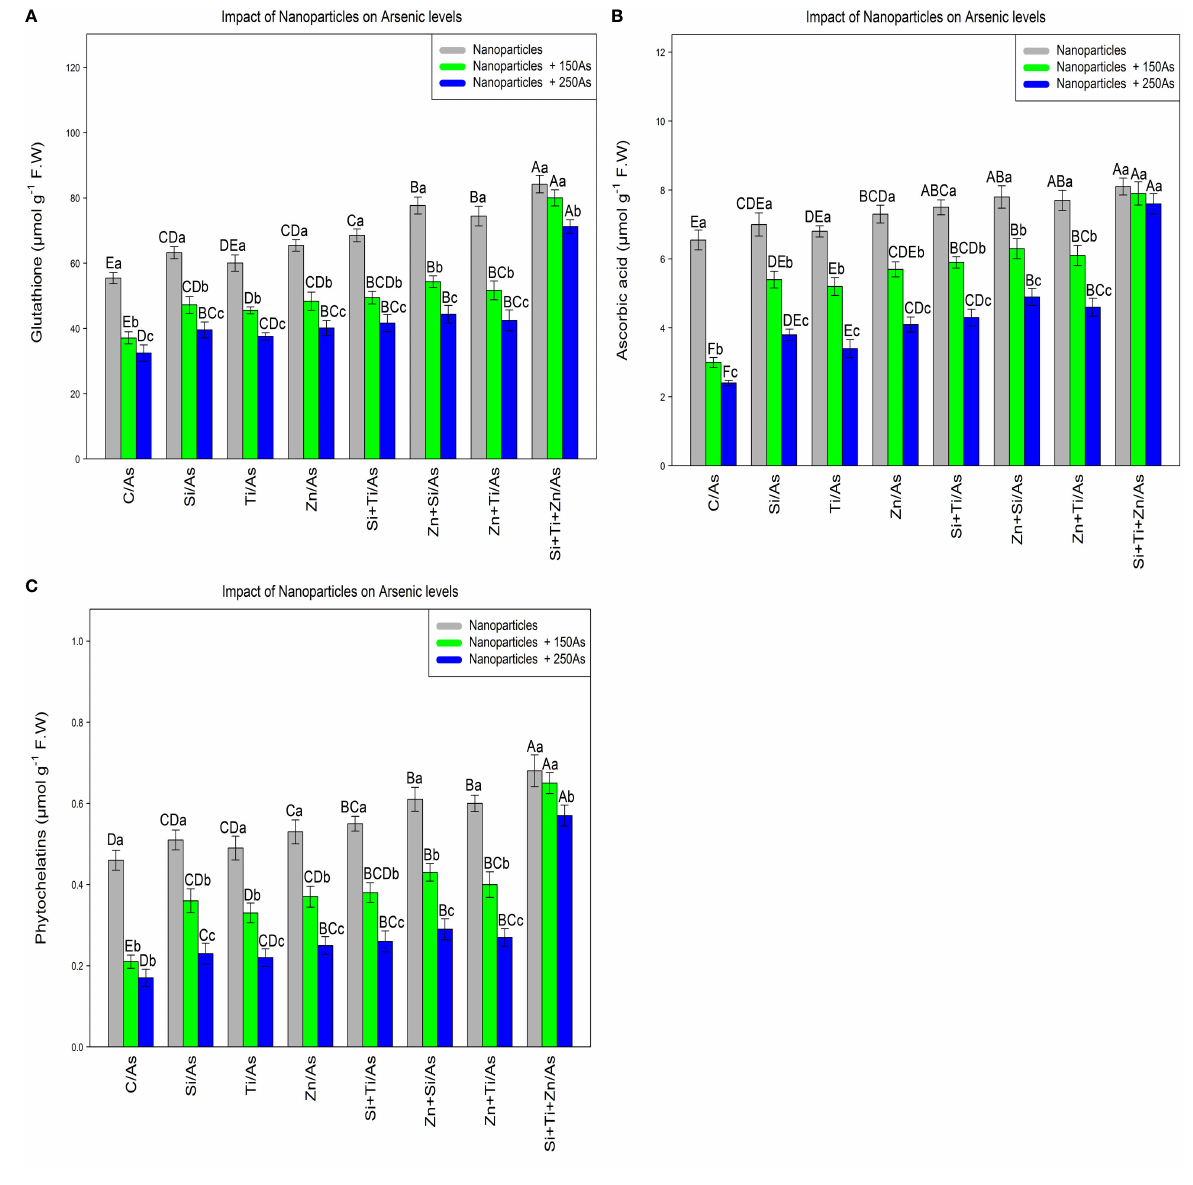
FIGURE 1 The impact of NPs alone and in combination on the concentration of glutathione (A) , ascorbic acid (B) and phytochelatins (C) in one-year-old Pleioblastus pygmaeus exposed to 150 and 250 µM As (four replicates). In this fi gure, the letters a, b, c, etc. indicated signi fi cant differences following the application of NPs with 150 and 250 µM As based on Tukey ′ s test (p<